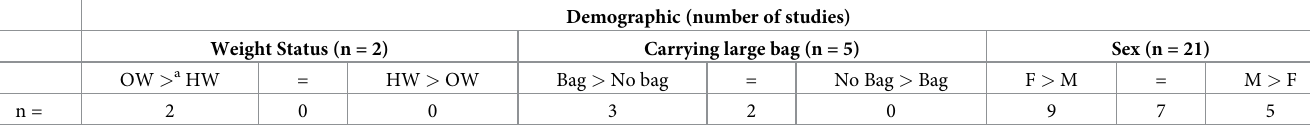
Table 1. Summary of previous significant effects in workplaces of demographics on avoidance of stair